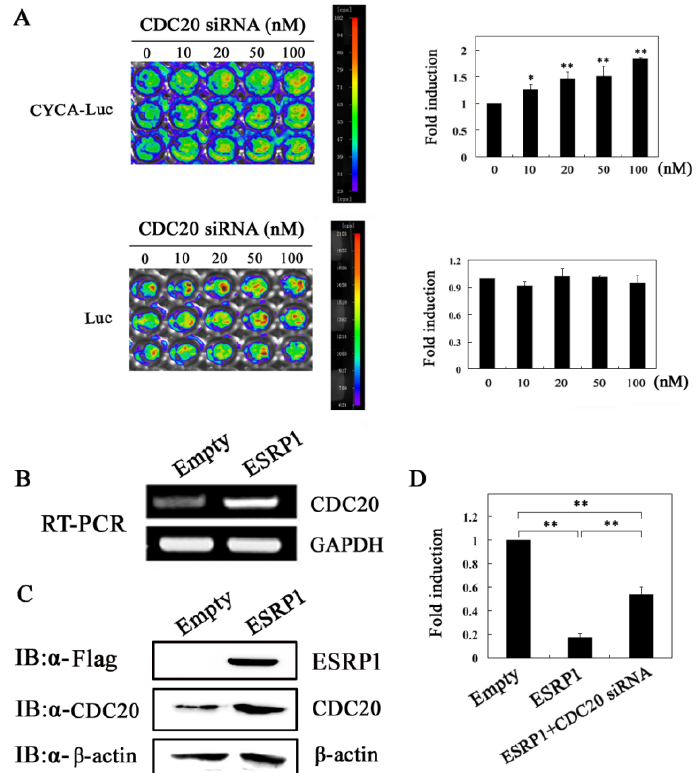
Figure 5. ESRP1 can increase the expression of CDC20 by inducing G1-phase arrest. ( A ) HeLa-Luc cells or HeLa-CYCA-Luc cells were seeded in 96-well plates, treated with CDC20 siRNA (0, 10, 20, 50, and 100 nM), and then imaged after 48 h. Images of siRNA-treated cells are shown on the left, whereas the normalized fold induction in luciferase signal activity upon siRNA treatment is shown on the right, with 1 corresponding to activity in untreated cells. Quantitative data represent the mean ± standard error ( n = 3 per group). Expression of CDC20 was assessed via RT-PCR ( B ) or Western blotting ( C ) in HeLa cells after overexpression of ESRP1, with an empty plasmid used as a negative control. ( D ) Hela-CYCA-Luc cells were transfected with the ESRP1 vector alone or together with CDC20 siRNA for 48 h, with empty vectors serving as negative controls, and then cells were lysed, and luciferase activity was measured. For normalization of CYCA-Luc activity, the signal (1 µ g protein) for control cells was set to 1. This experiment was repeated three times ( n = 3); error bars indicate standard error. * p < 0.05, ** p < 0.01.